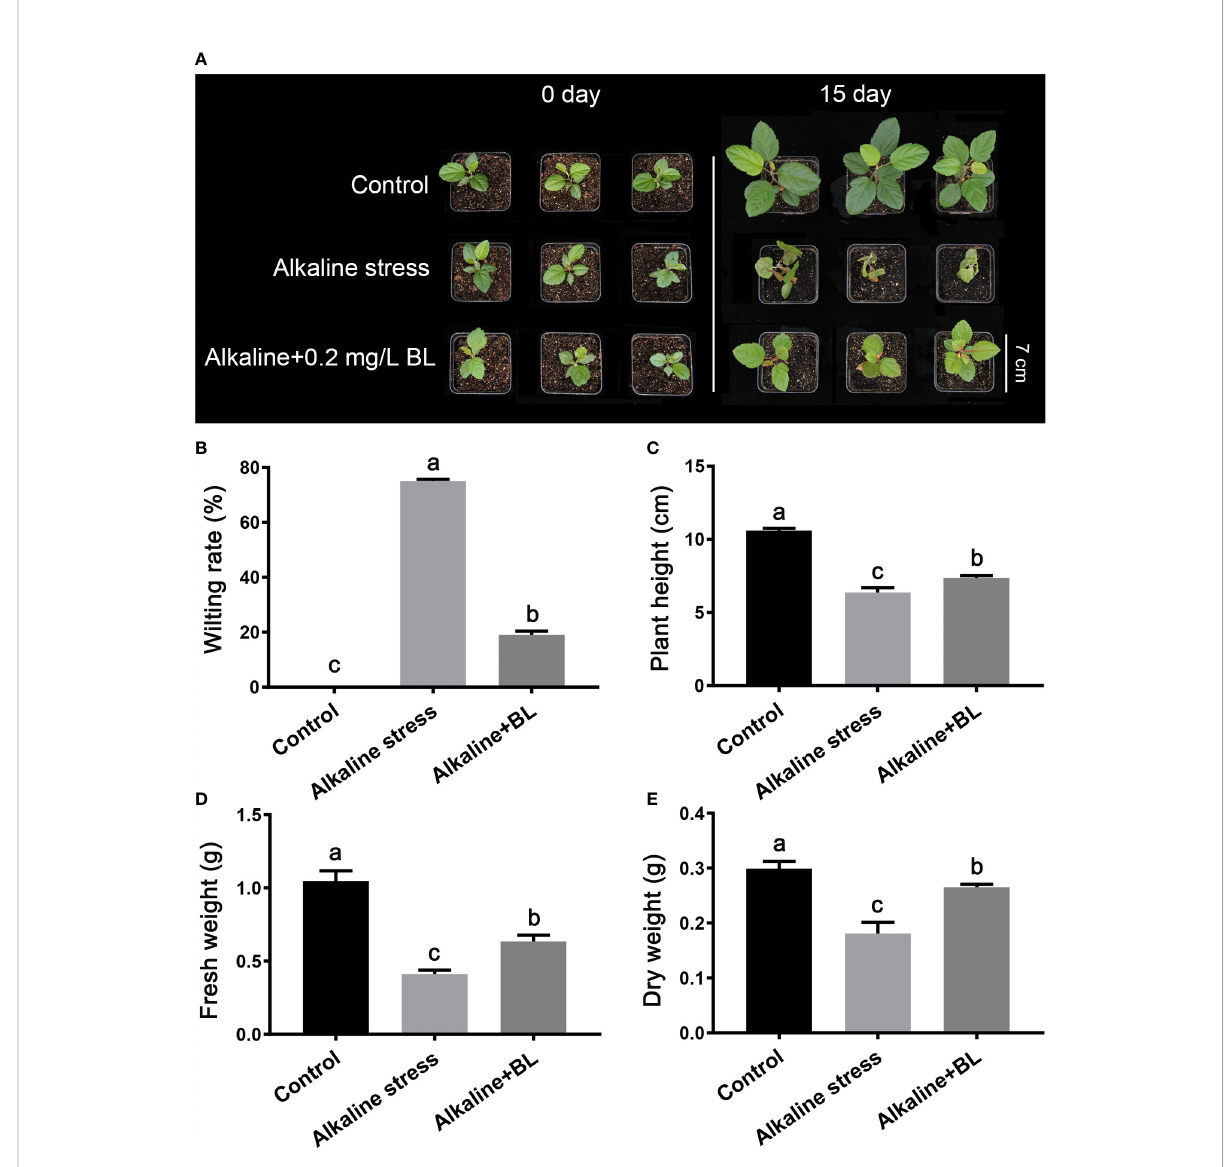
FIGURE 1 The aboveground phenotypes of M. hupehensis seedlings treated with alkaline stress and 0.2 mg/L BL. (A) The phenotypes of M. hupehensis seedlings treated with alkaline stress and BL at day 0 and day 15. The scale bar represents 7.0 cm. Effects of exogenous BL on wilting rate (B) , plant height (C) , fresh weight (D) , and dry weight (E) of the seedlings after alkaline stress for 15 days. Data represent the mean ± SD of triplicate experiments. Different lowercase letters indicate signi fi cant differences according to Fisher ’ s least signi fi cant difference ( P <